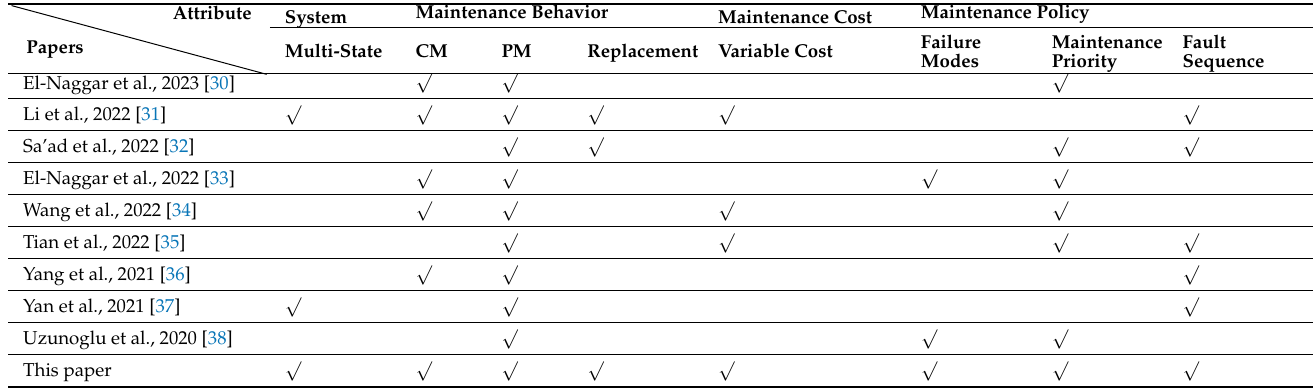
Table 1. The comparison of the work done in the related literature and in this